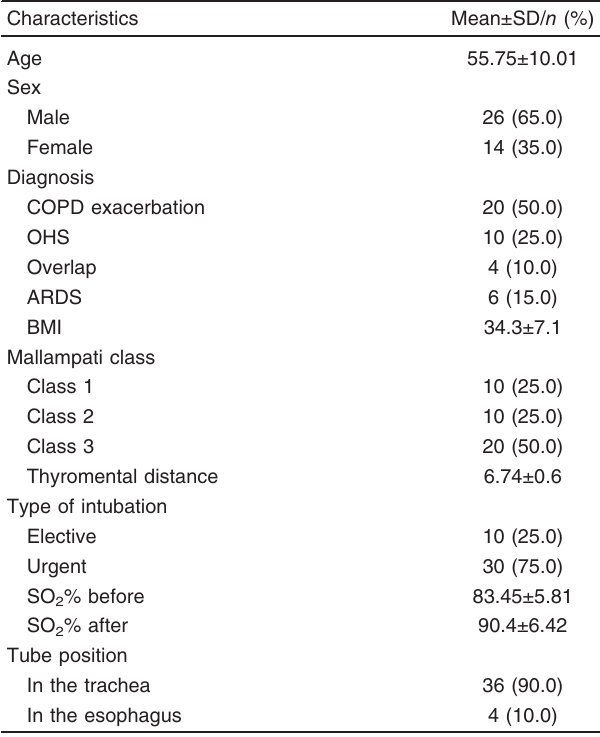
Table 1 General characteristics and airway data of the studied sample